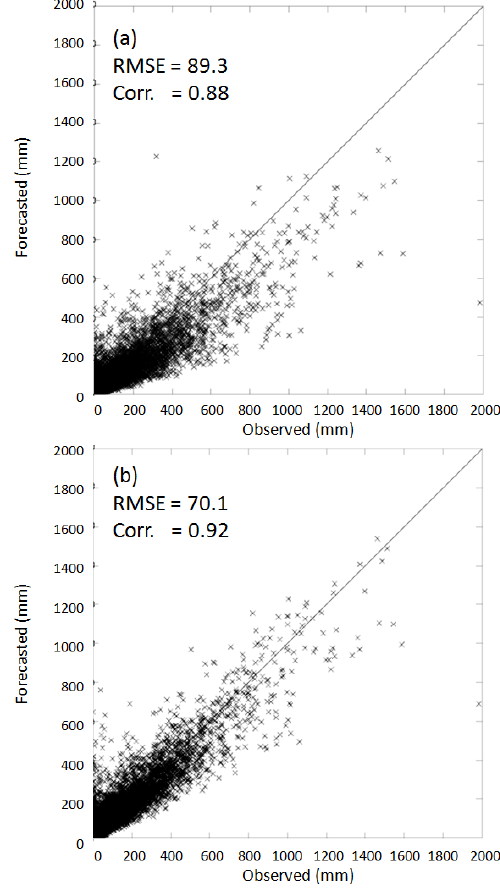
Fig 5. The forecasted (y axis) and observed (x axis) rainfall accumulations of the 2 Fig. 5. The forecasted (y-axis) and observed (x-axis) rainfall ac- dependent westward-moving typhoons (from 1989 to 2006) for all rain gauge stations: 3 cumulations of the dependent westward-moving typhoons (from (a) TRCM06; and (b) W-TRCM12. 4 1989 to 2006) for all rain gauge stations: (a) TRCM06; and (b) W-